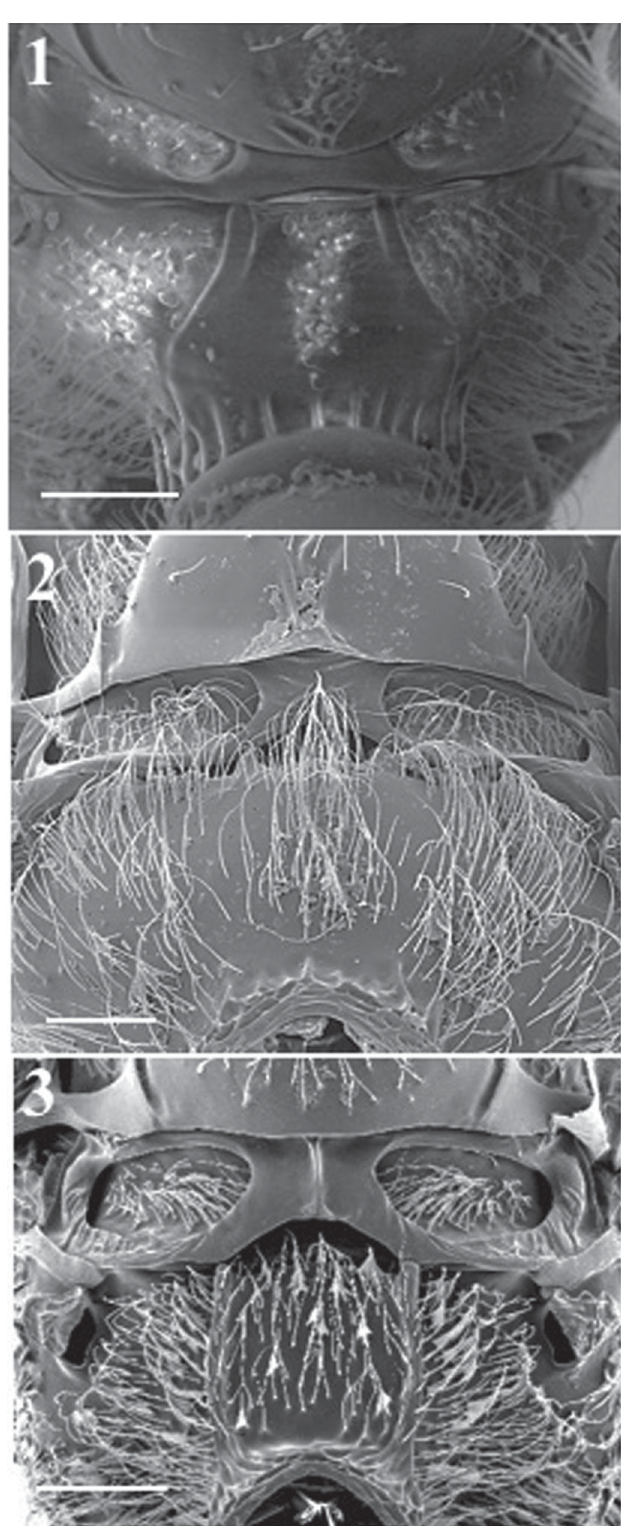
Fig. 9. Types of propodeum. 1 . Alloxysta arcuata (Kieffer, 1902). 2 . A. victrix (Westwood, 1833). 3 . Phaenoglyphis americana Baker, 1896. Scale bars: 50